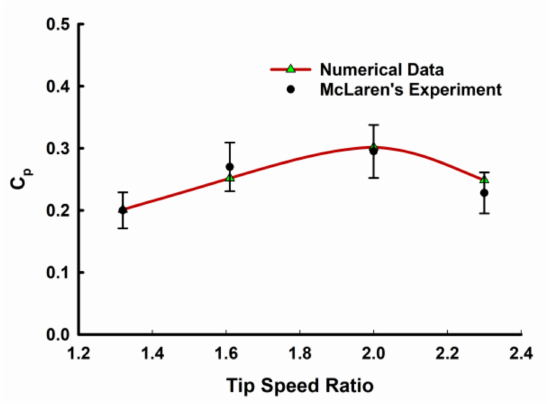
Figure 6. Validation of numerical results to McLarens experimental